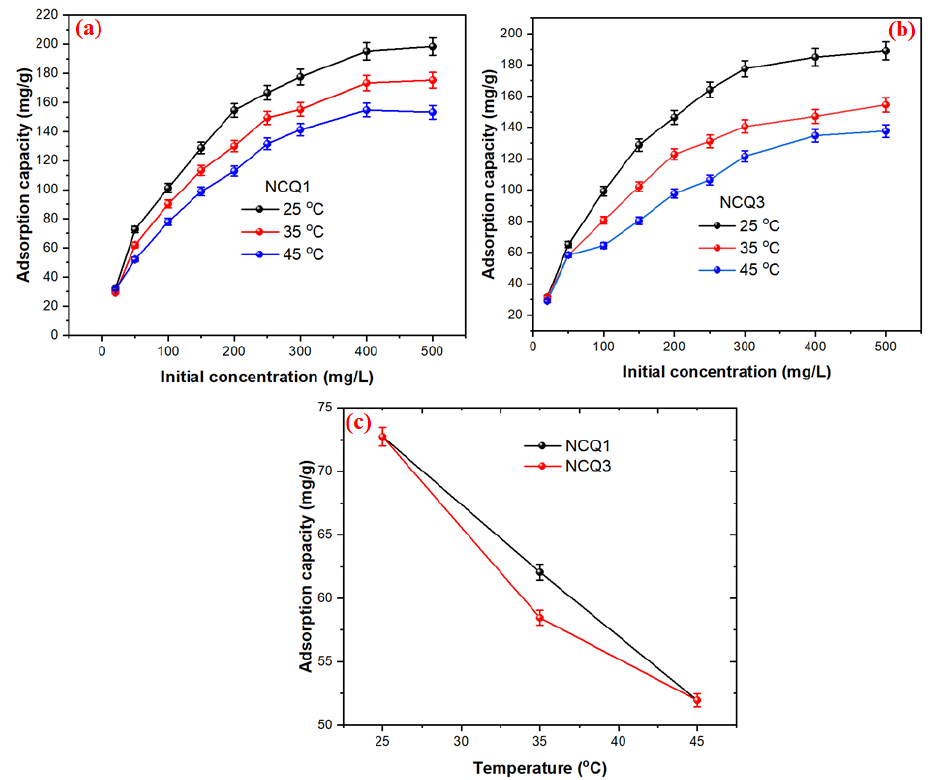
Figure 6. ( a ) Effect of initial CV concentration on adsorption of CV dye onto NCQ1 ( b ) and NCQ3 ( c ) Effect of temperature on adsorption of CV dye onto both NCQ1and NCQ3